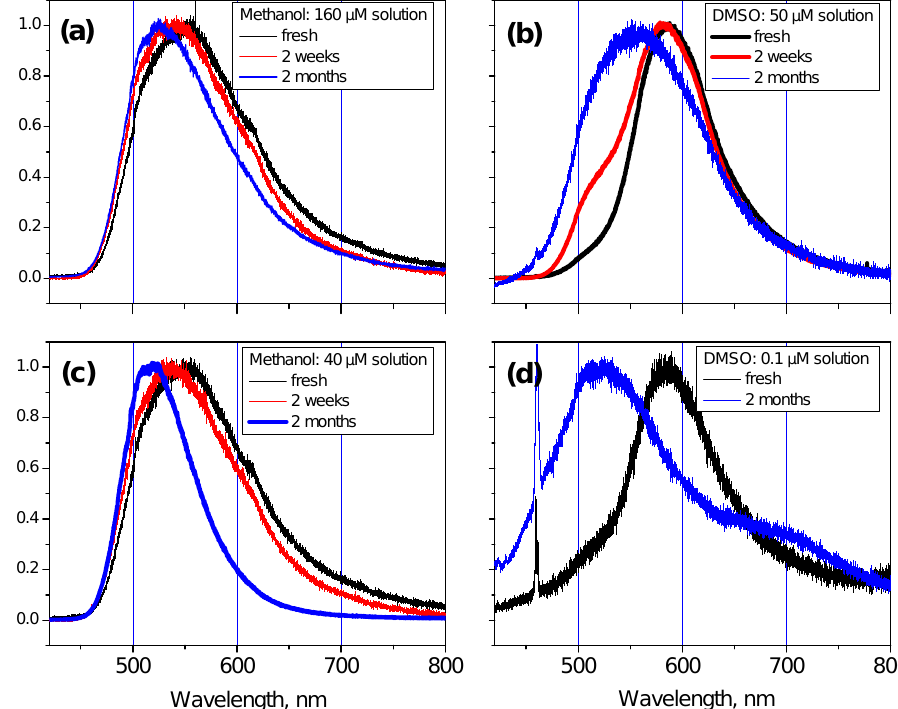
Figure 4. Time dependence of the FL spectra of M solutions in methanol ( a , c ) and DMSO ( b , d ). The spectra of solutions with moderate ( a , b ) and low ( c , d ) M concentrations are shown. All the spectra were normalized to one by dividing each spectrum by its highest value. The sharp peaks in ( d ) at approximately 460 nm are due to the emission of DMSO